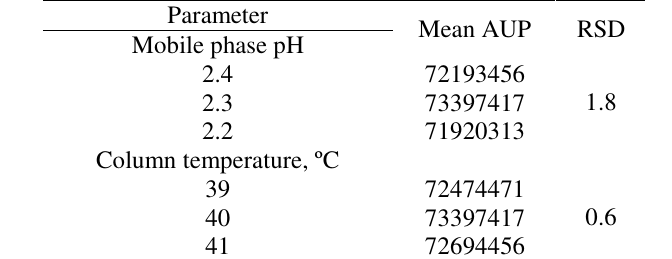
Table 6. Effect of pH of the mobile phase and column temperature variation on the AUP of insulin (Robustness)